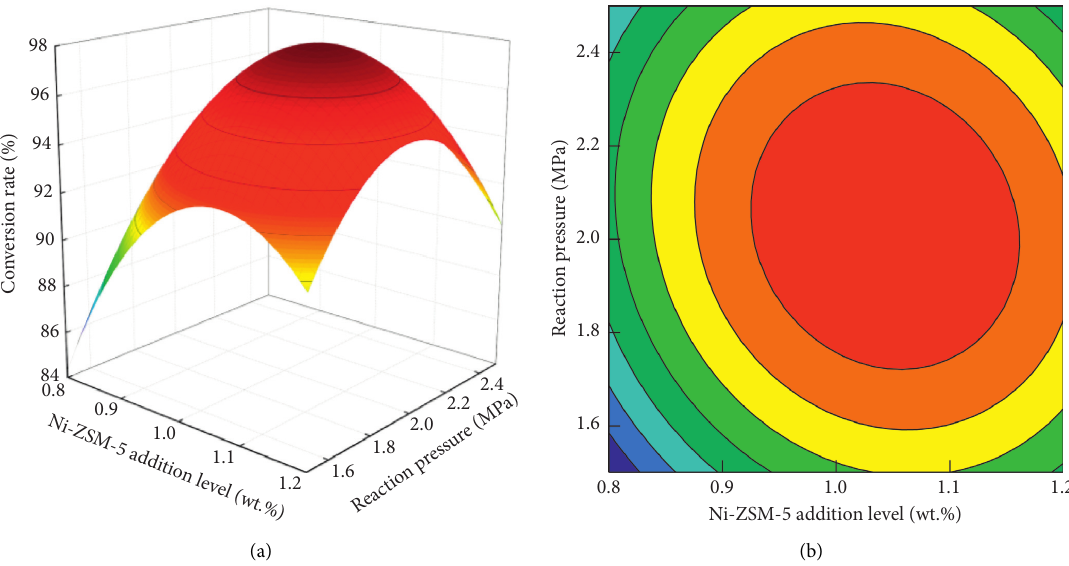
Figure 12: The interaction of the Ni-ZSN-5 addition level and reaction pressure on